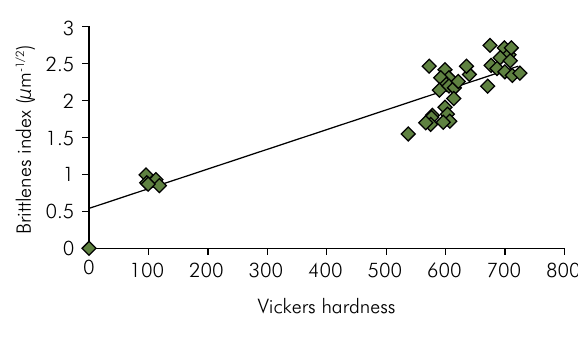
Figure 1. Pearson correlation between Vickers hardness (x) and Brittleness index